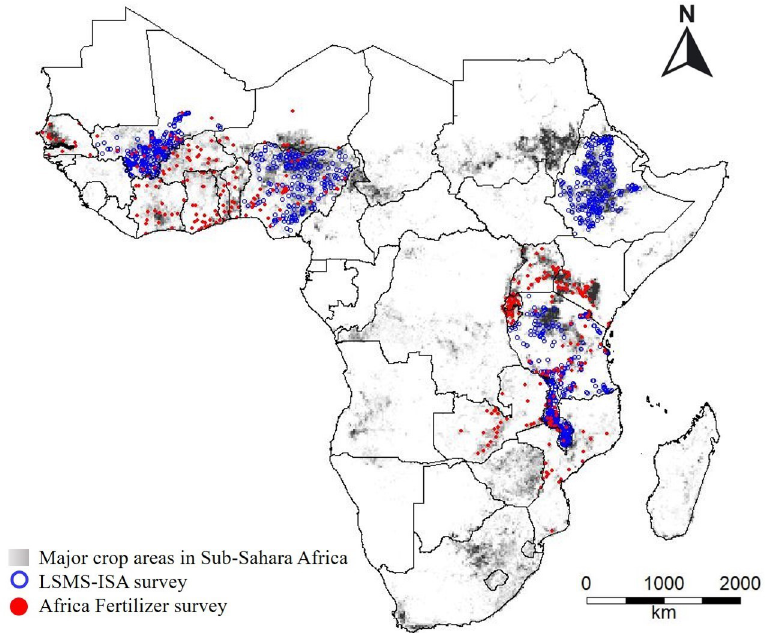
Fig 4. Major cropland area in Sub-Saharan Africa (gray areas), distribution of the urea price data from Africa Fertilizer (red dots) and the Living Standards Measurement Survey-Integrated Surveys on Agriculture (LSMS; blue dots), and country boundaries (black